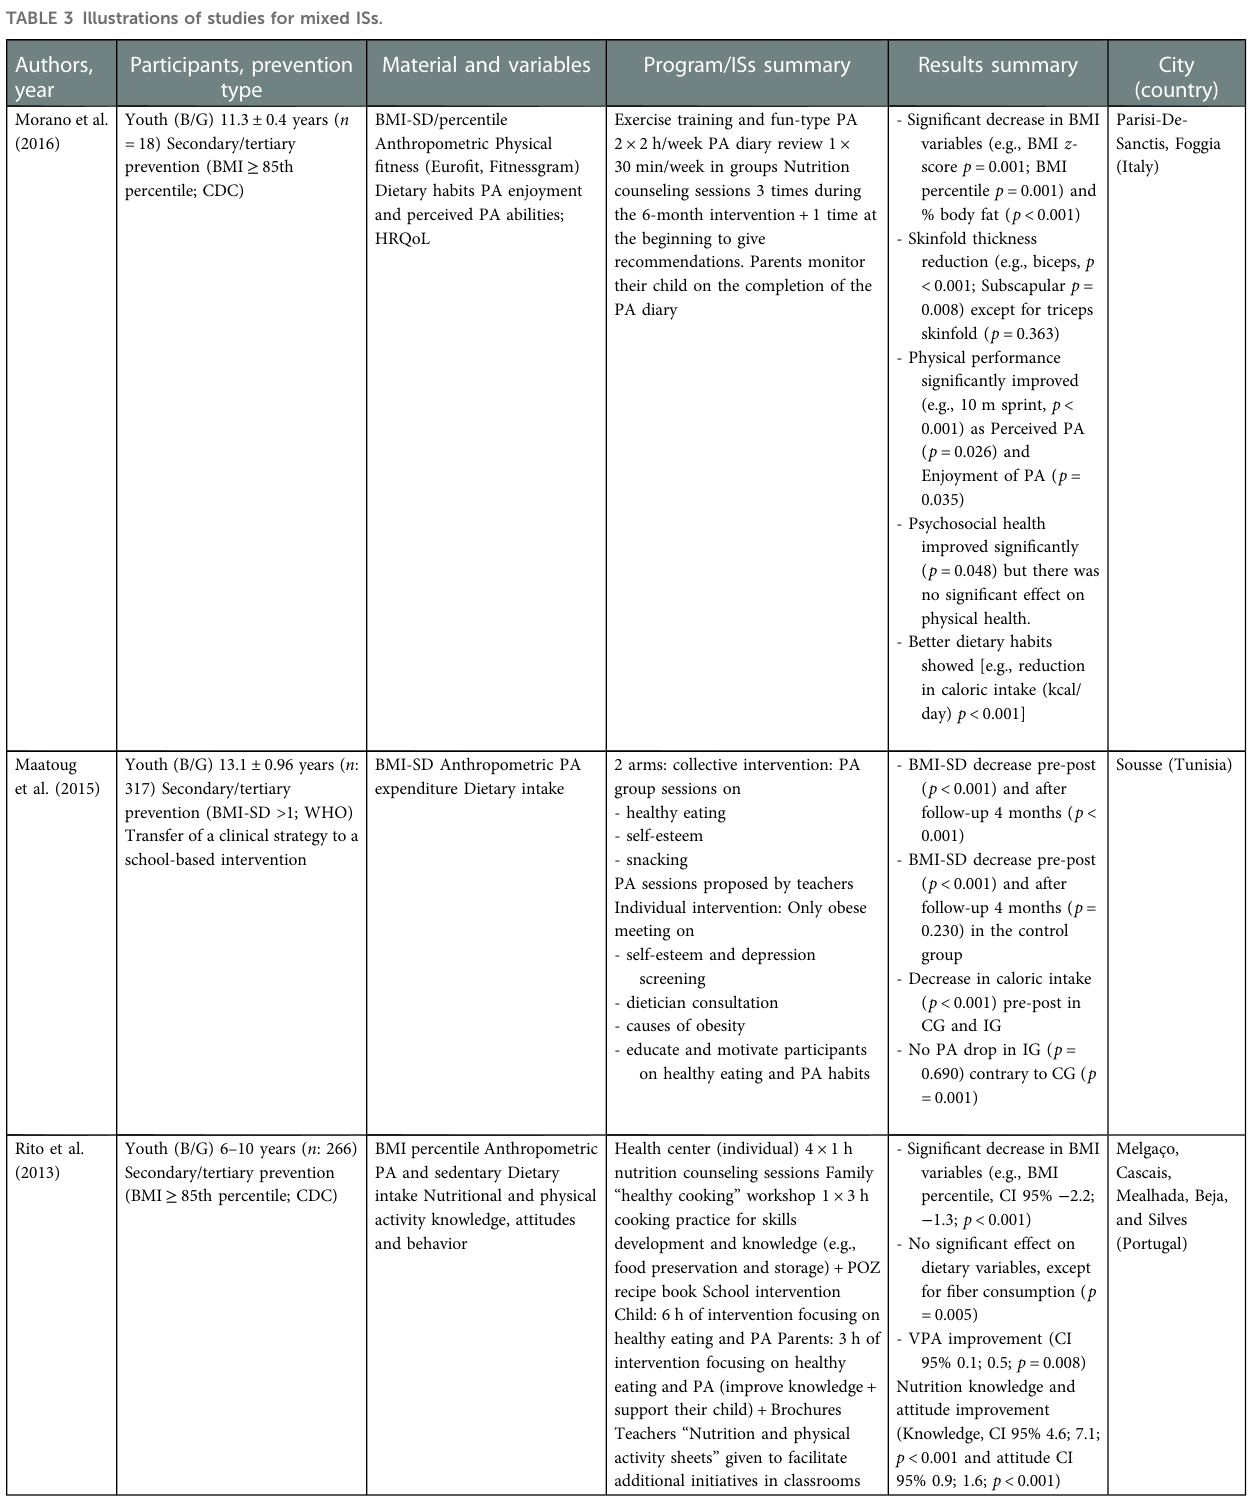
TABLE 3 Illustrations of studies for mixed